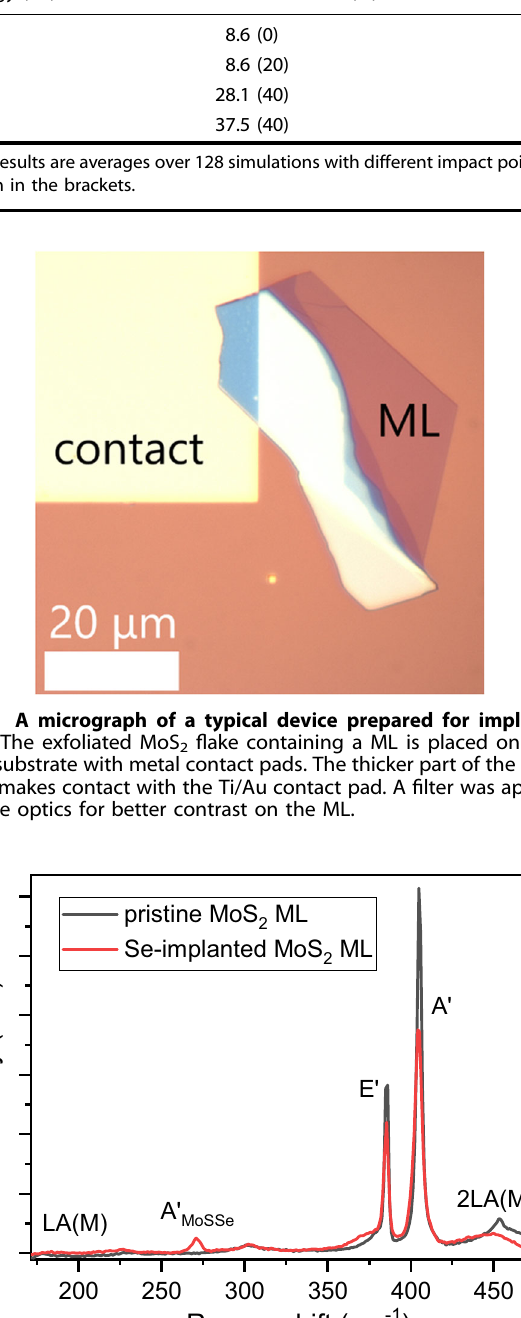
Table 1. Probabilities by MD simulations of the most likely outcomes of a Se ion colliding with MoS 2 ML. Energy (eV)